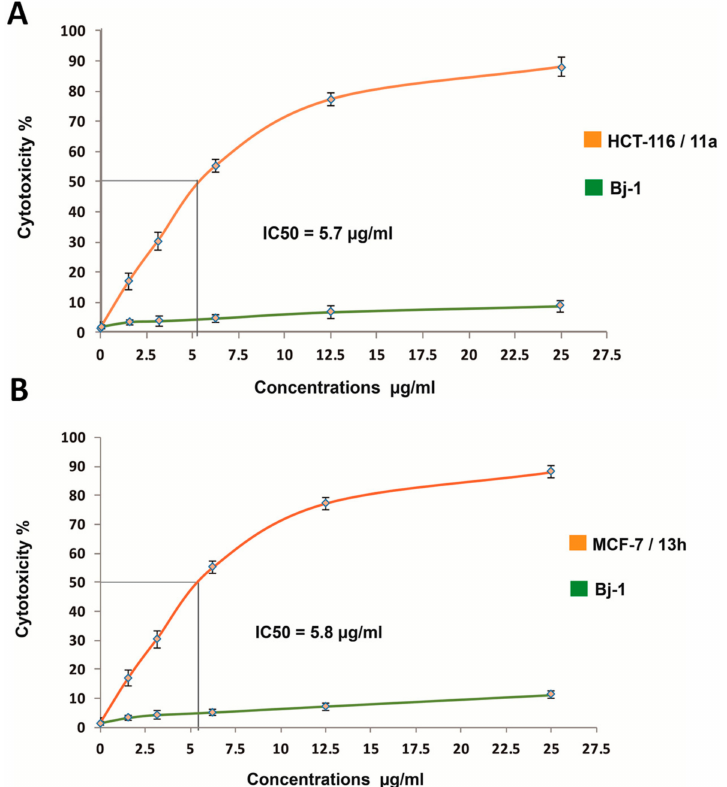
Figure 2. Cytotoxicity (%) dose-response curves of increasing concentrations for selected synthesized spiro pyrazole-oxindole congeners against cancerous cells. ( A ) Dose-response curve of 11a congener against HCT-116 as compared to BJ-1. ( B ) ( A ) Dose-response curve of 13h congener against MCF-7 as compared to BJ-1. IC50 values in µ g / mL were calculated by probit analysis using an Excel-based